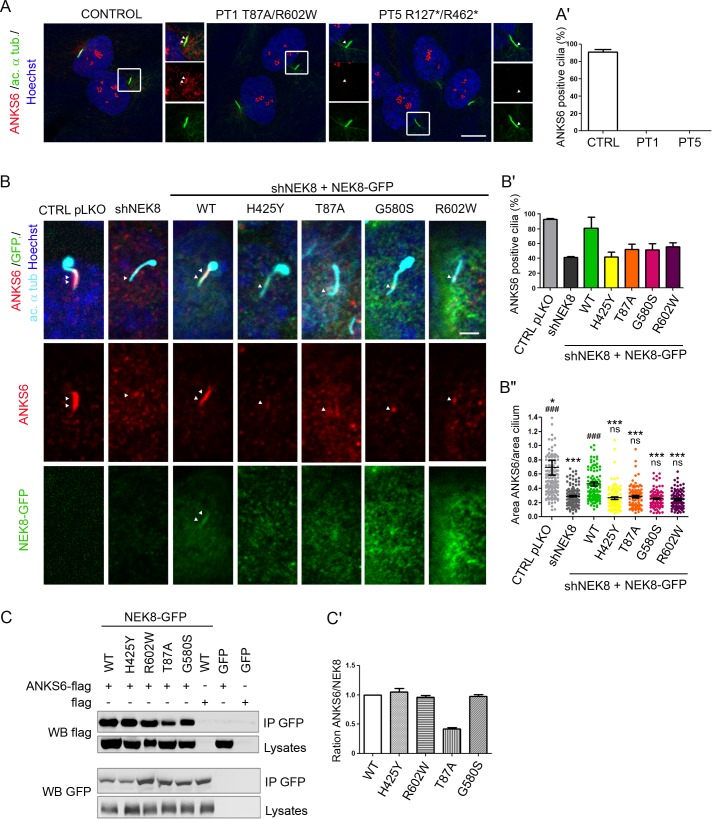
NEK8 mutations prevent ANKS6 localization at the INVS compartment and interaction in patient fibroblasts and shNEK8 mIMCD3 cells.(A) Serum-starved fibroblasts from control (CTRL) and affected individual II.1 of families 1 and 5 (PT1 and PT5) were stained for ANKS6 (red) and acetylated α-tubulin (green). Insets are magnifications of ciliary axonemes, showing that ANKS6 staining is lost in patient fibroblasts. Scale bar, 10 μm. (A’) Graph (mean ± SEM of three independent experiments) representing the percentage of cells with ANKS6 staining at cilia in control and patient fibroblasts. (B) Control pLKO, shNEK8 and shNEK8 re-expressing WT or mutant NEK8-GFP cells were fixed after 5 days of culture and stained for ANKS6 (red), GFP (green), acetylated α-tubulin (cyan) and nuclei (Hoechst, blue). ANKS6 staining at the ciliary axoneme is decreased in shNEK8 mIMCD3 cells as well as in cells re-expressing the mutant constructs. Scale bar, 5 μm. (B’-B”) Graphs (mean ± SEM of three independent experiments) representing the percentage of cells with ANKS6 staining at cilia (B’) and the ratio between the areas of ANKS6 staining and total cilium (ANKS6/acetylated α-tubulin) (B”). Statistical analyses by Kruskal-Wallis post-hoc test following ANOVA, ns = non significant,*p < 0.05, ***p < 0.001 when samples are compared to shNEK8 + NEK8-GFP WT and ###p < 0.001 to shNEK8. (C) Lysates from HEK293T cells co-expressing GFP-tagged WT or mutant forms of NEK8 and Flag-ANKS6 were immunoprecipitated with an anti-GFP antibody. The co-immunoprecipitation of GFP-NEK8 and Flag-ANKS6 constructs was analysed by western-blot (WB) using GFP and Flag antibodies. (C’) Quantification of ANKS6 (Flag) versus NEK8 (GFP) band intensities showing that p.T87A NEK8 mutation decreases the interaction with ANKS6.